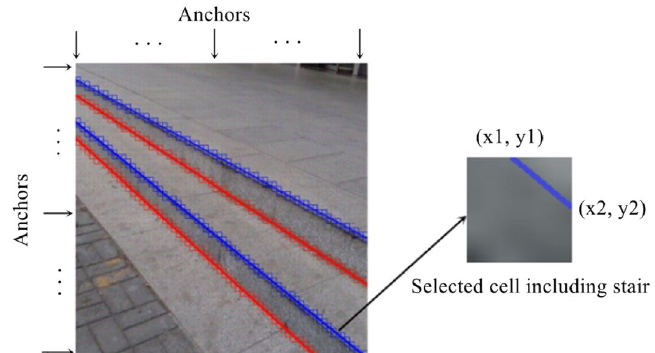
Figure 2. Illustration of our stair feature representation. The whole image on the left is divided into 64 × 64 anchors, and the anchors (including stair lines) are detected on the right. The normalized coordinates of the two endpoints relative to the upper left corner of the anchor are